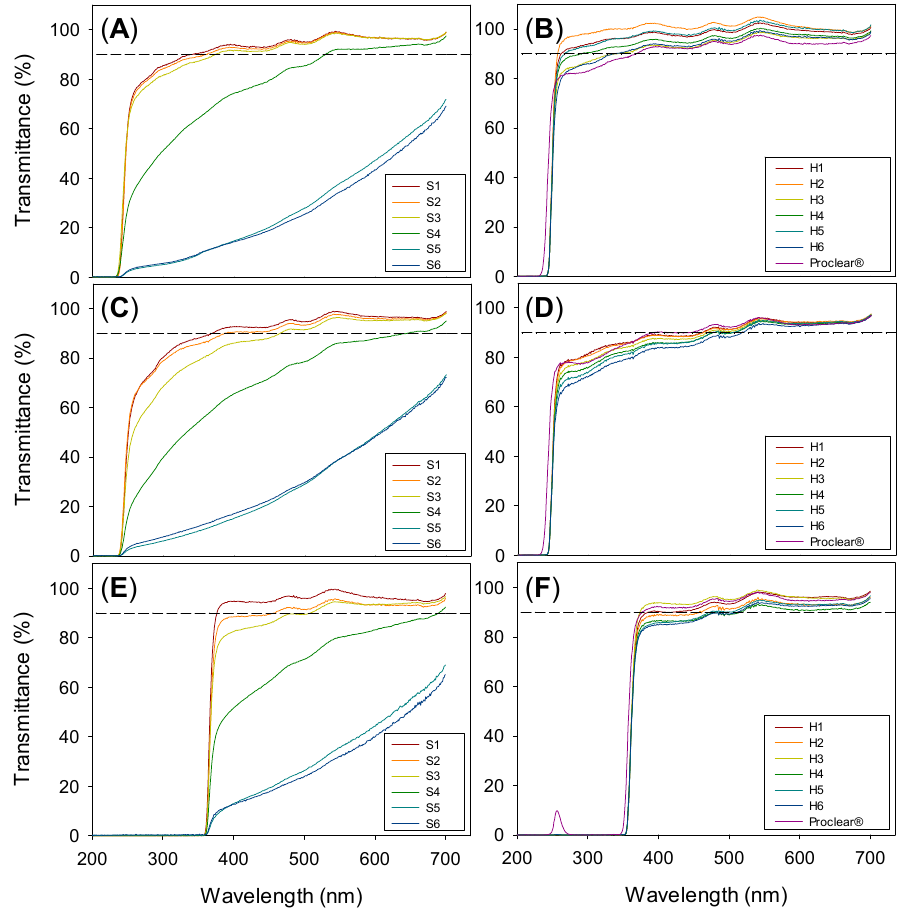
Figure 2. Light transmission of silicone ( left ) and HEMA ( right ) hydrogels swollen in water ( A , B ), SLF ( C , D ) and resveratrol loading solution ( E , F ). Dashed lines indicate the acceptance value of 90% transmittance.